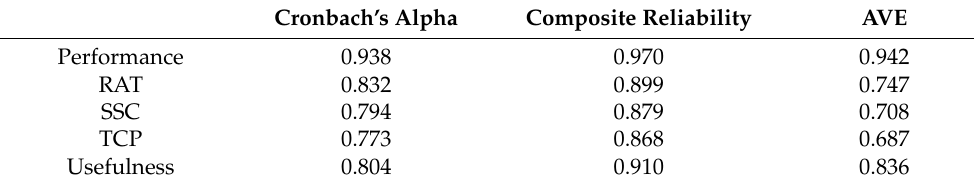
Table 4. Validity and reliability.